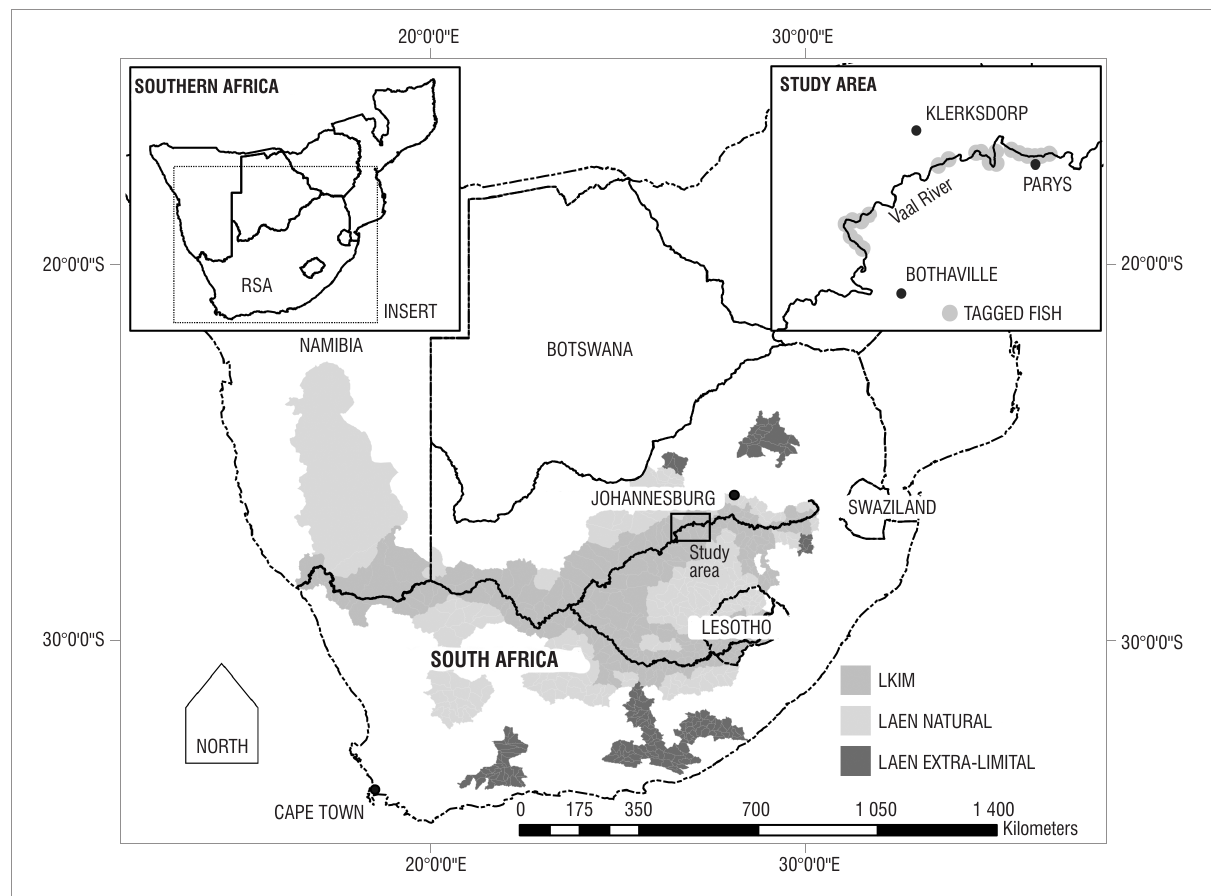
Figure 1: Map showing the distributions of Labeobarbus kimberleyensis (LKIM) and L. aeneus (LAEN) and the location of the study area on the Vaal River, southern